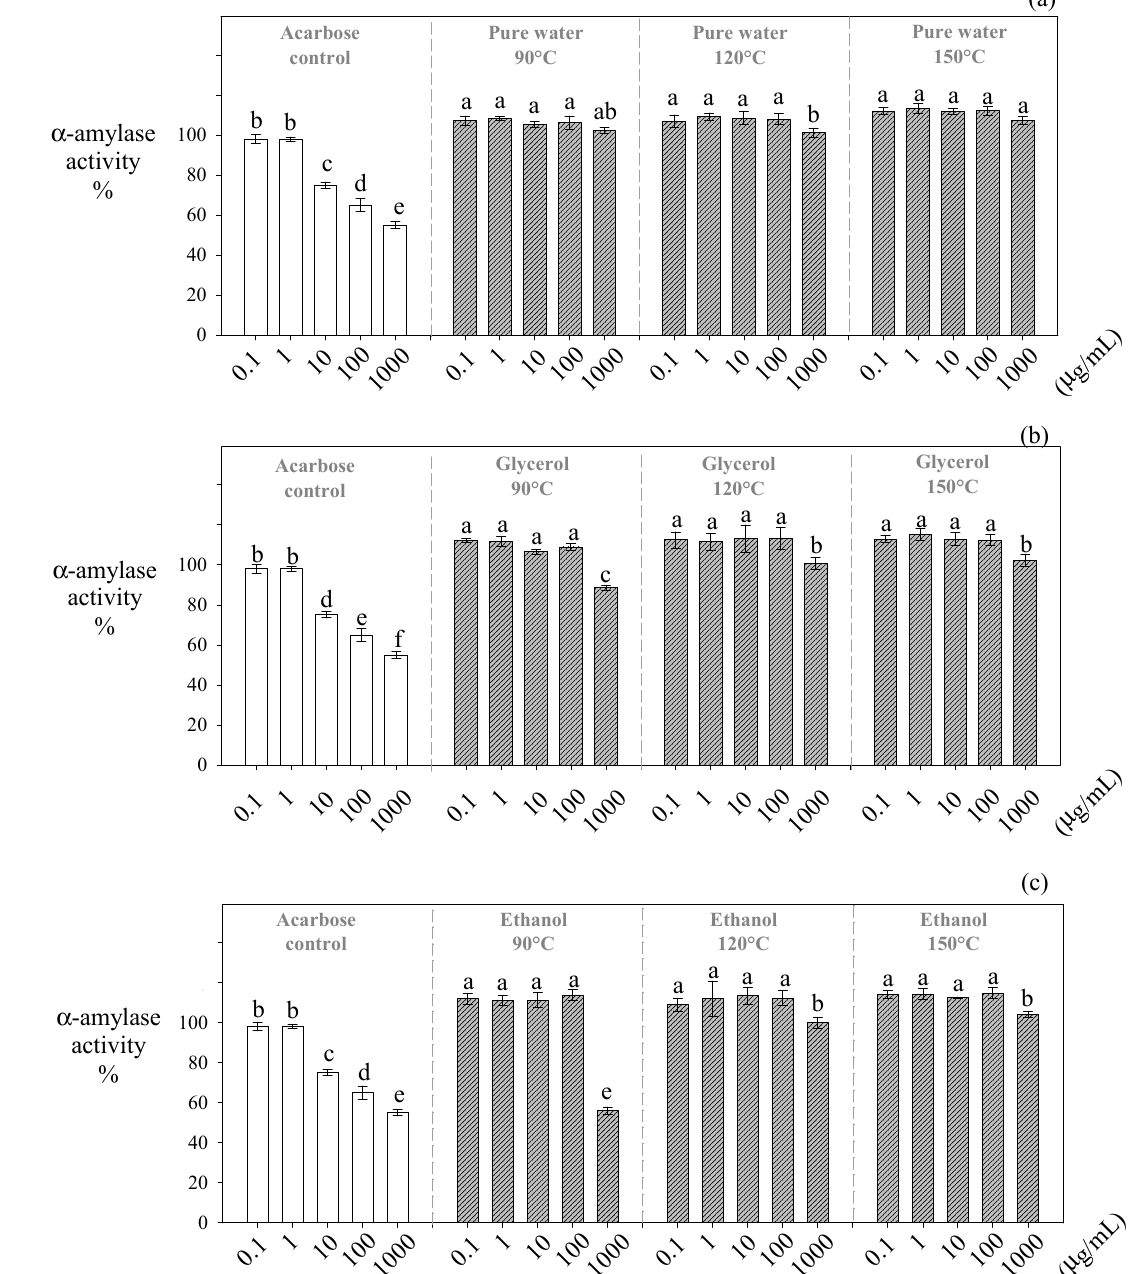
Figure 3. Inhibitory effect of Carm é n è re pomace extracts obtained by HPLE at different temperatures using protic solvents on the α -amylase activity. ( a ): pure water, ( b ): glycerol, and ( c ): ethanol. The different low-case letters in the bars show the significant inhibitory differences ( p < 0.05) between the different HPLE temperatures and extract concentrations for the same HPLE